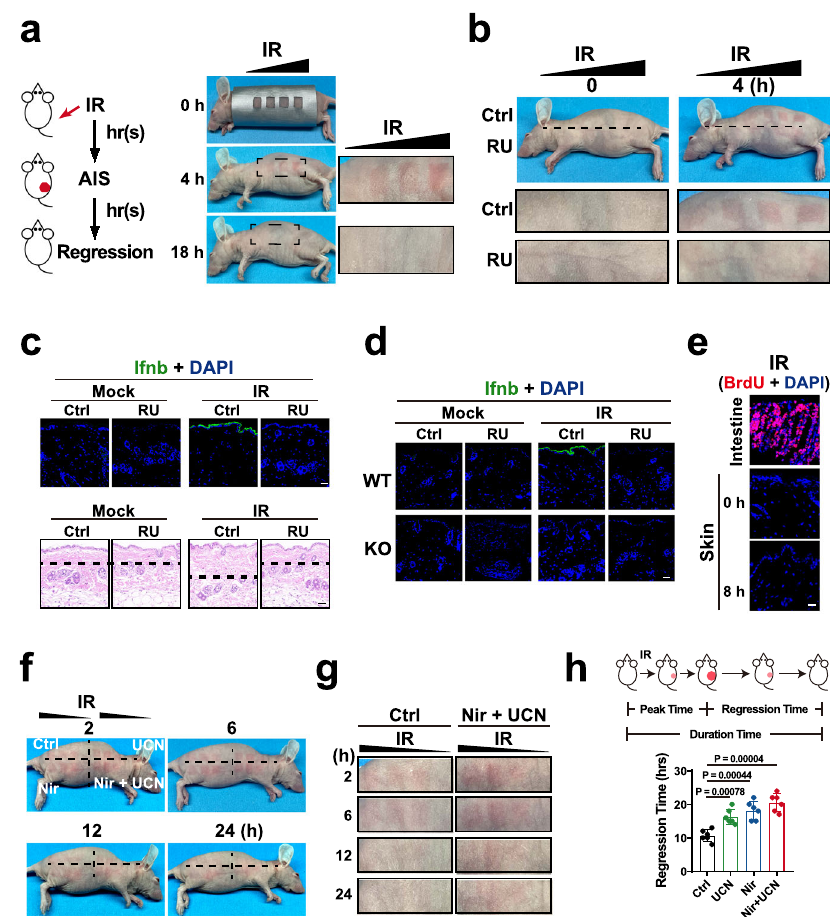
Fig. 8 | Flexsurveillance model suggests that low dose IR might activate cGAS- mediatedAISviarepairableDNA.a Left:Schematicshowingthetimescheduleof acute immune surveillance (AIS) and late immune surveillance (LIS). Right: Repre- sentative images of the nude mice at noted times after irradiation (IR) (ranging 150 – 600 mJ/cm 2 ). b Representative erythema images of the mice pretreated with 150 μ g/cm 2 RU.521 for 1h at noted times after IR (ranging 150 – 600 mJ/cm 2 ). n =6. c Skin immuno fl uorescence (IF) (upper) and hematoxylin-eosin (HE) (lower) staining images of the RU.521-pretreated nude mice at 4h after 300 mJ/cm 2 IR. Scalebar=100 μ m.Upper:Blue:Dapi;Green:Ifnb(anti-Ifnbantibody).Lower:Black dashed lines are used to evaluate the swell. d Skin IF images of the cGAS wild type (WT) and knock out (KO) mice at 4h after 400mJ/cm 2 IR. Blue: Dapi; Green: Ifnb